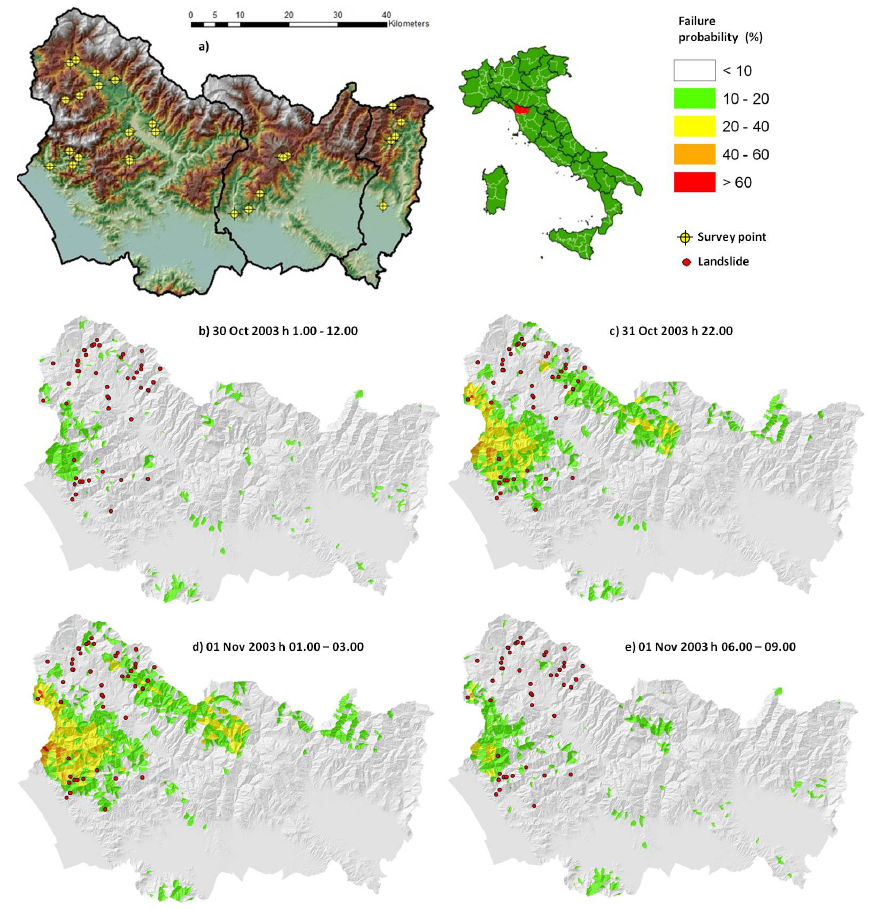
Fig. 3. Study area (a) and simulations of slope instability forecasts according to different time frames ( b to f